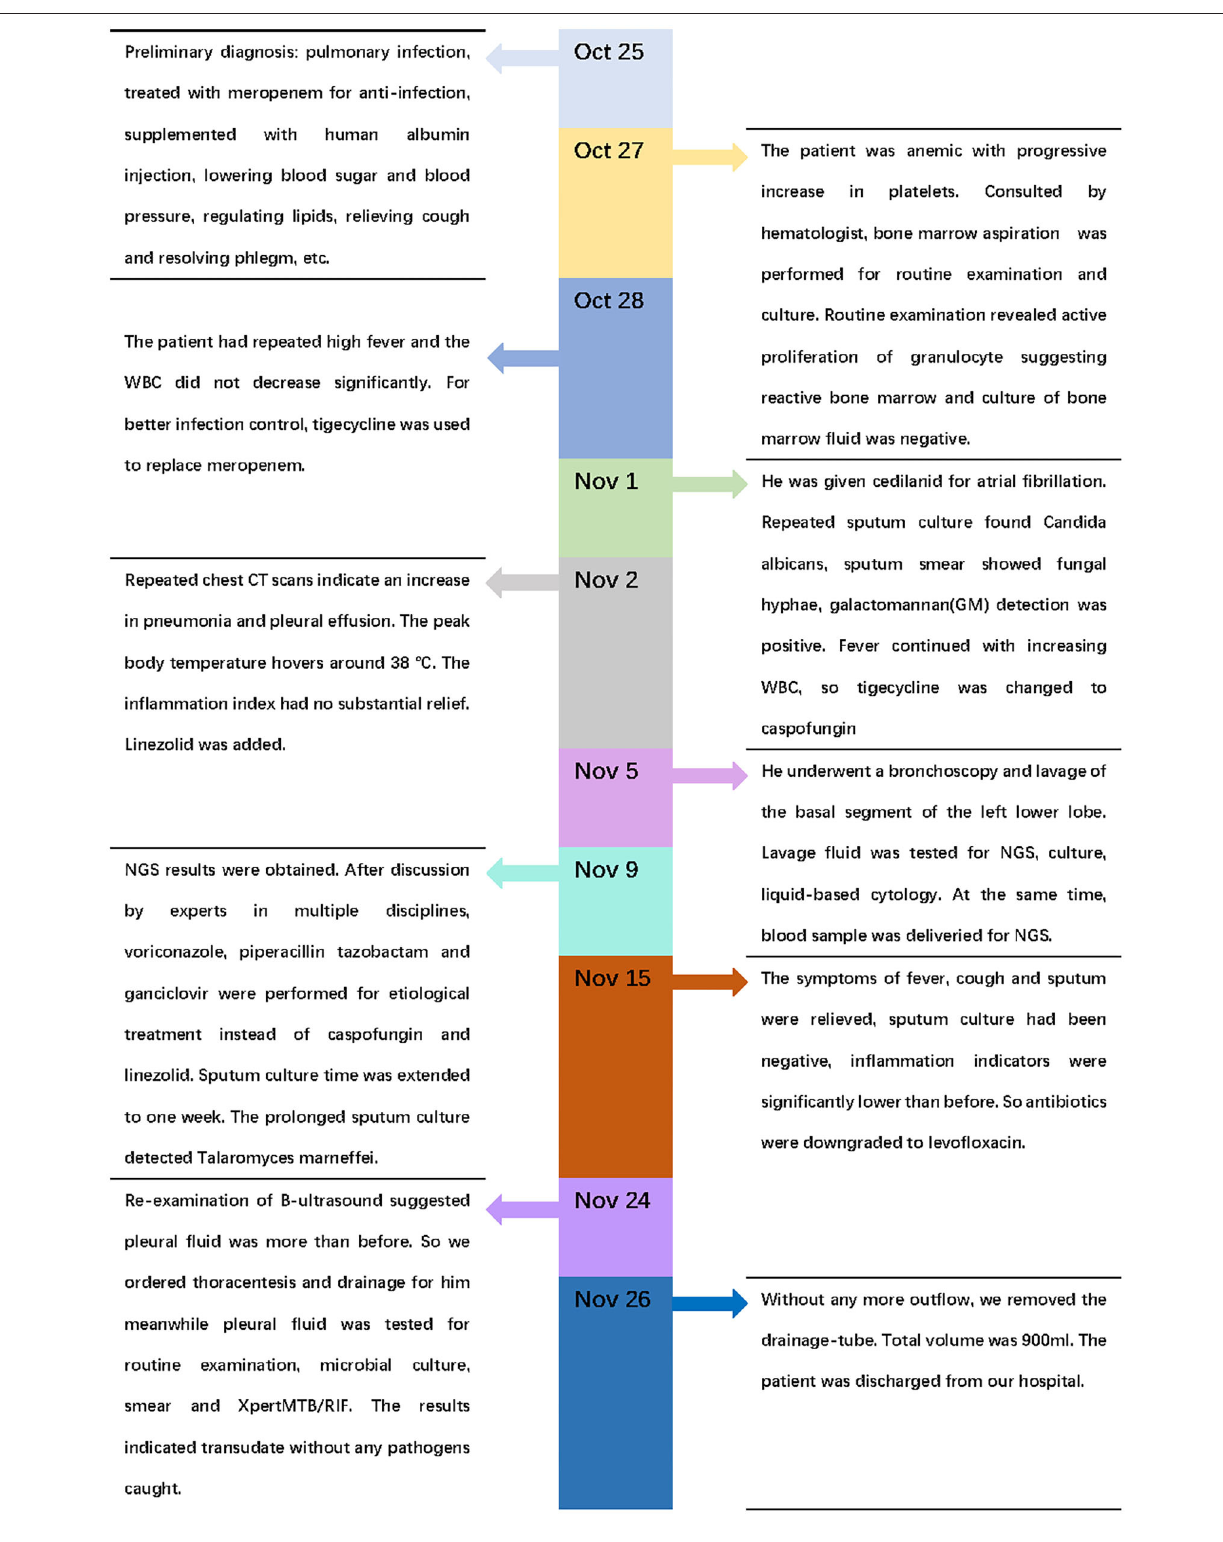
FIGURE 5 | Timeline of the